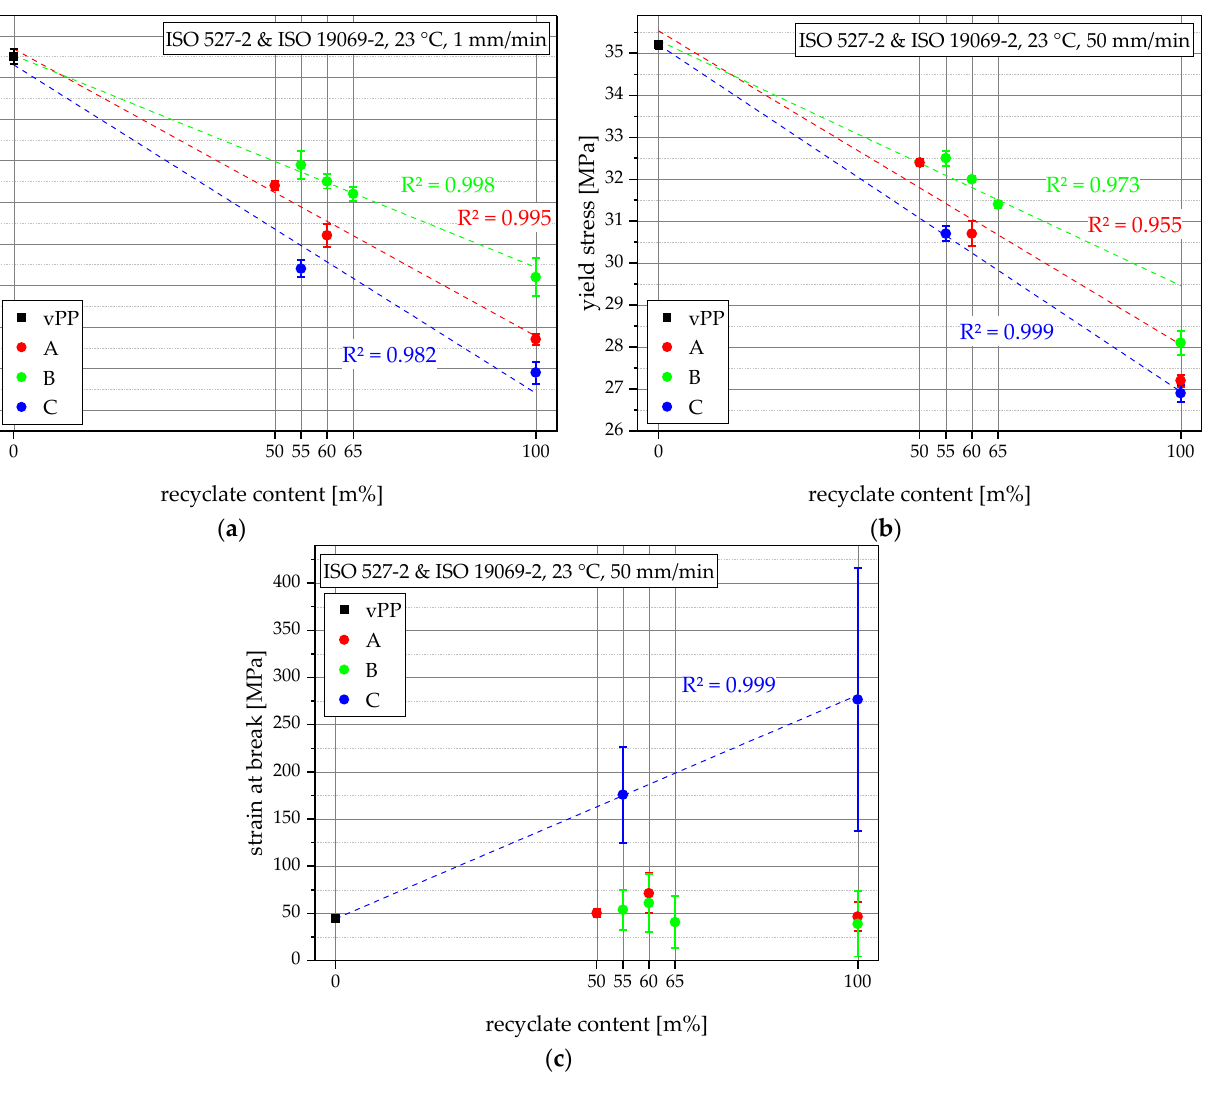
Figure 6. Graphical illustration of tensile modulus ( a ), yield stress ( b ), and strain at break values ( c ) for all materials.